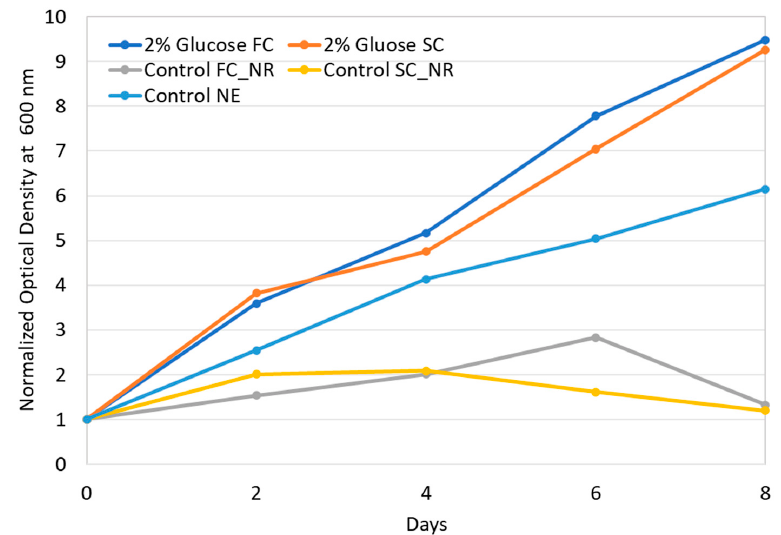
Figure 4. Growth curves comparison between cells electroporated with standard (SC) and flow- cuvette (FC) systems. Only magnetic nanoparticles were used in this experiment. Three control experiments were performed: (i) control FC_NR refers to cells electroporated with a flow cuvette and a growth in medium without glucose (no recovery); (ii) control SC_NR refers to cells electroporated with a standard cuvette and a growth in medium without glucose (no recovery); (iii) control NE refers to cells not digested and not electroporated. Optical density values were normalized by dividing all measuring points by the initial value (day